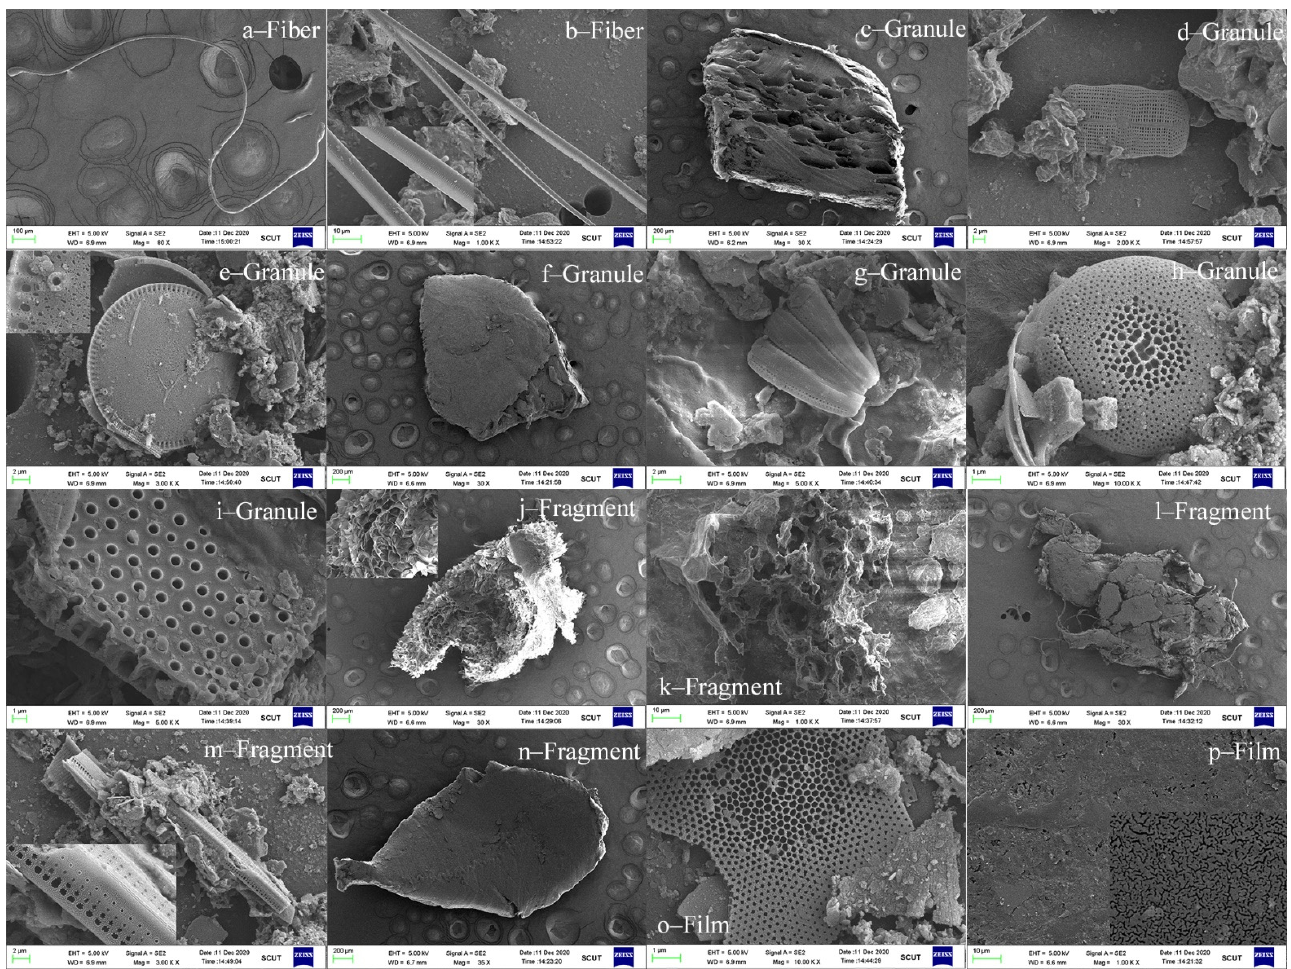
Figure 5. SEM photomicrographs of selected MP particles.